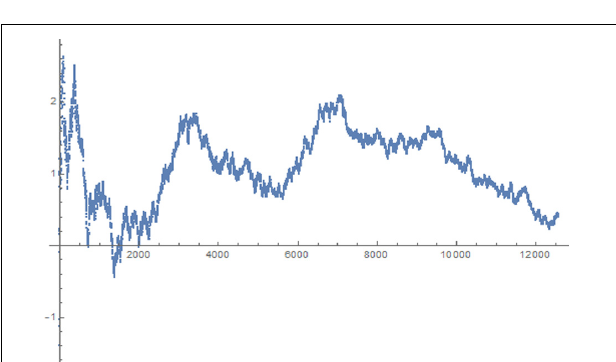
FIGURE 3 | Sequential analysis of data by computing a cumulative z-score from the percentage of positive stimuli obtained after each